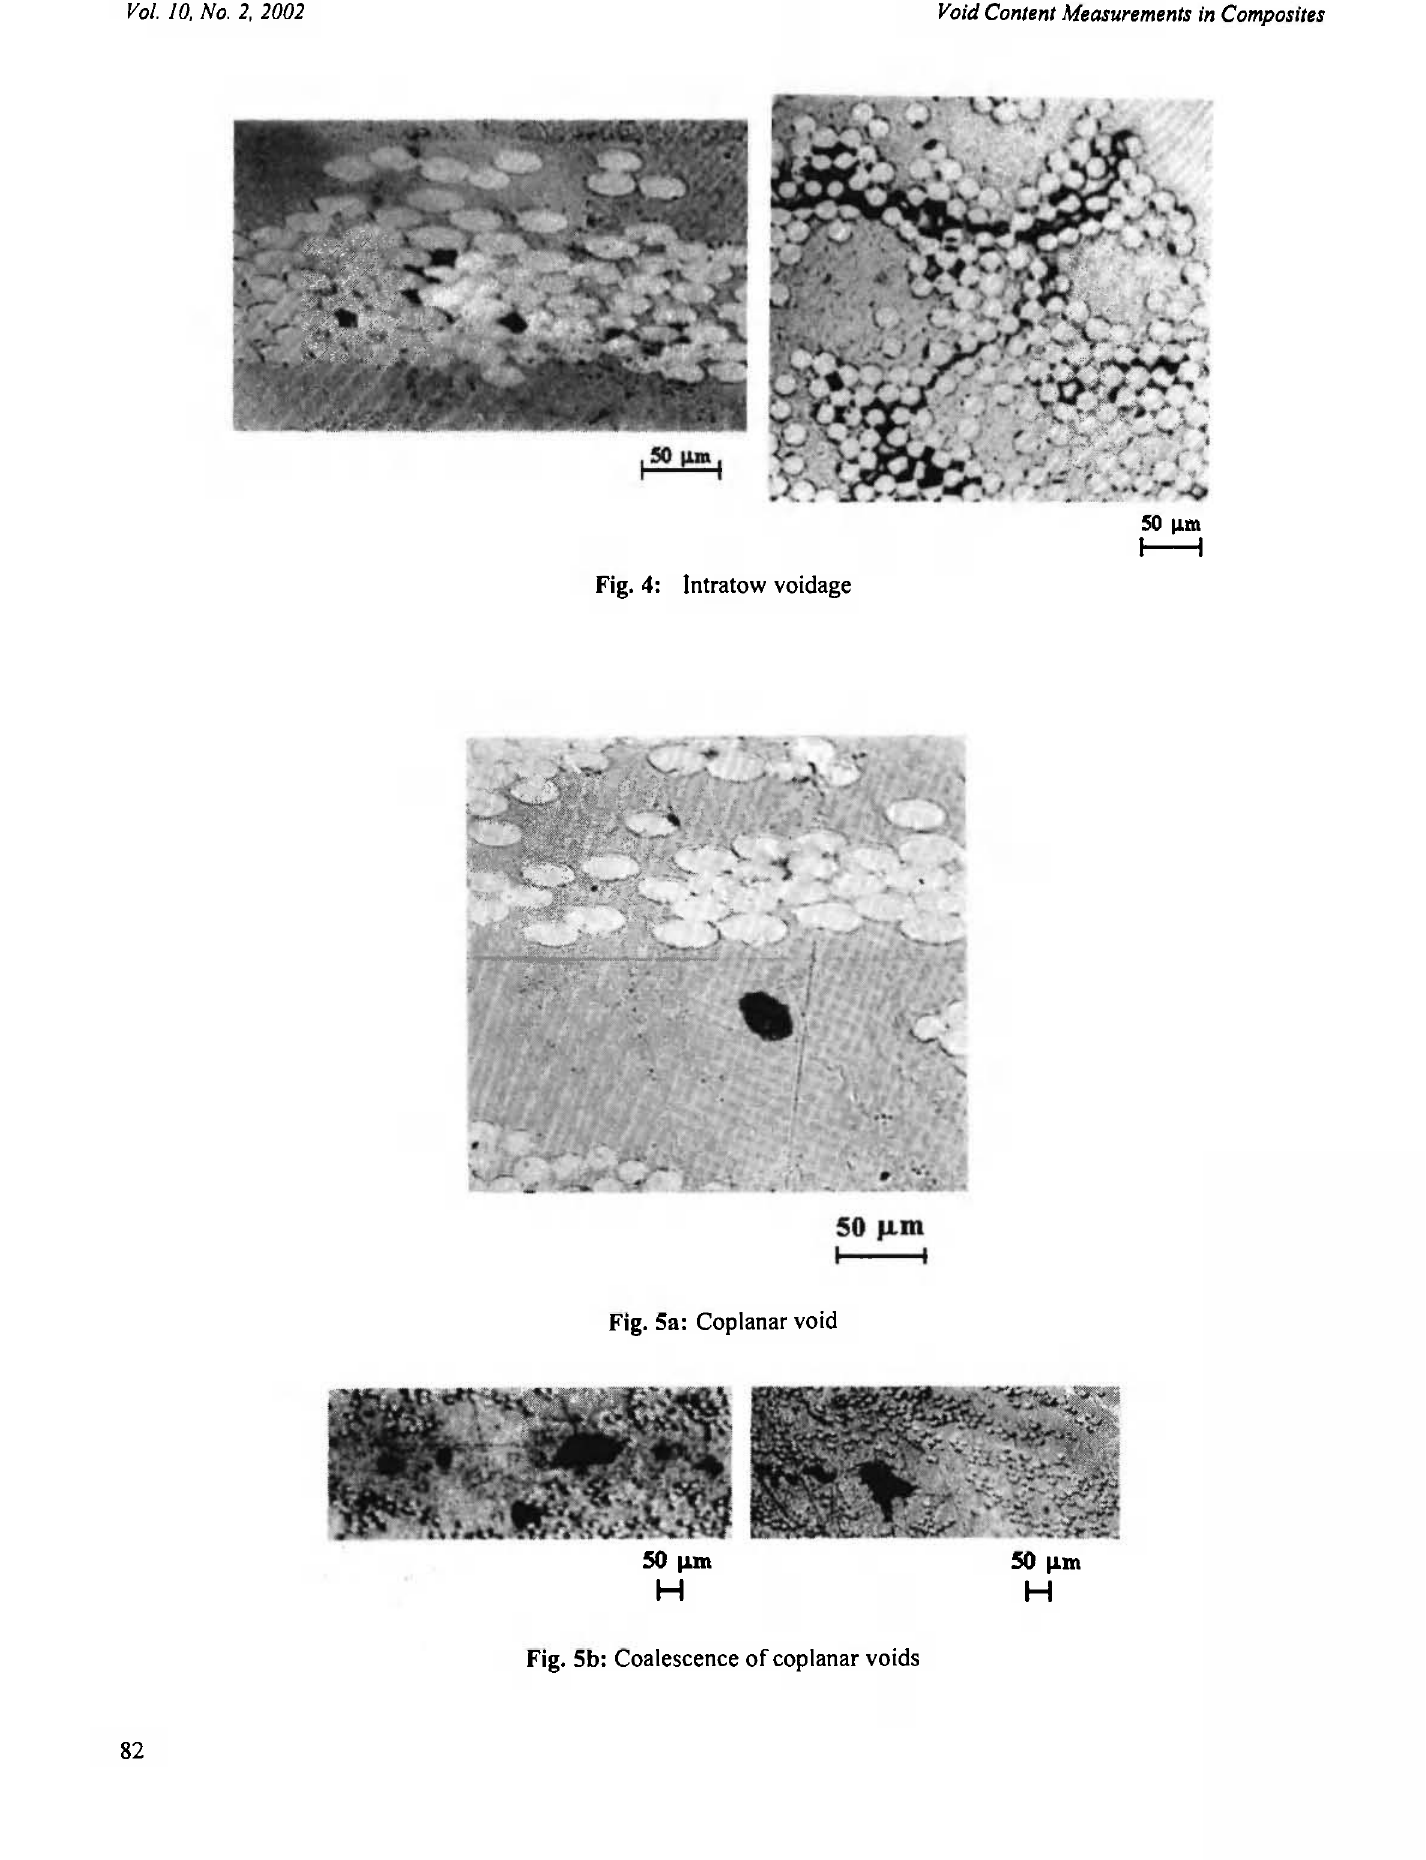
Fig. 5b: Coalescence of coplanar